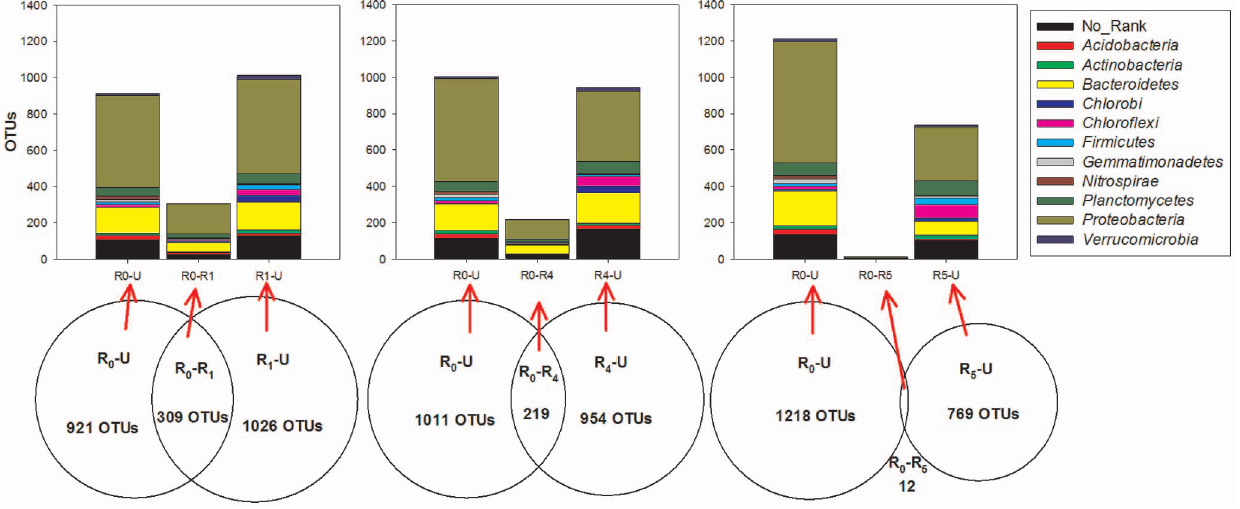
Figure 4. Venn of the bacterial communities of R 0 vs R 1 , R 0 vs R 4 and R 0 vs R 5 based on OTU (3% distance), and the taxonomic identities of the shared and unique OTUs at the phylum level (Phyla percentages below 1.0% are not shown). R 0 –U, R 1 –U, R 4 –U and R 5 –U represent the unique R 0 , R 1 , R 4 and R 5 communities, and R 0 –R 1 , R 0 –R 4 and R 0 –R 5 refer to shared communities.